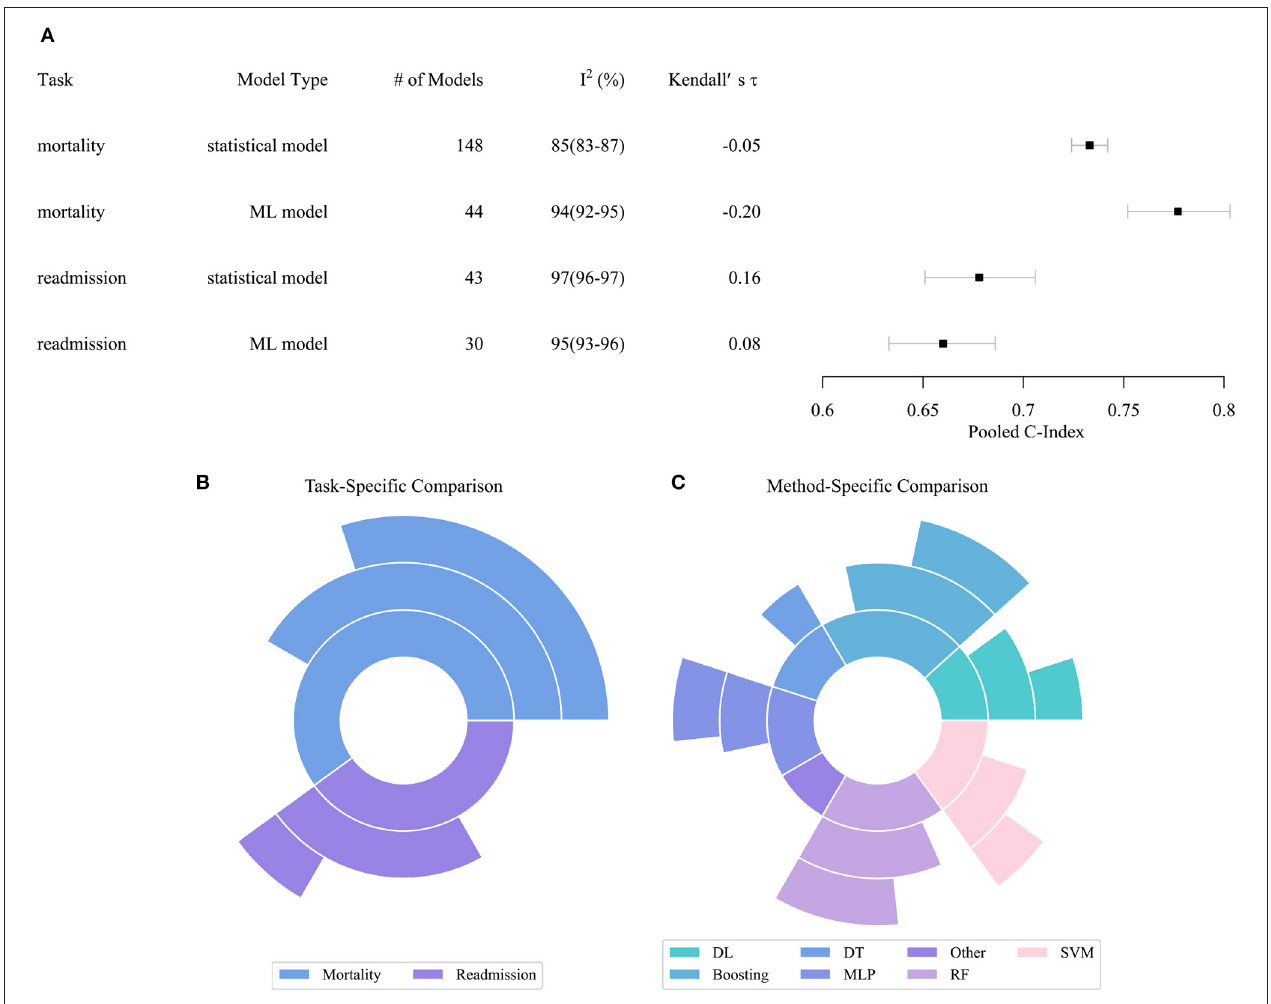
FIGURE 2 | Performance distribution of statistical and ML models. (A) Pooled C-index of meta-analysis with respect to tasks and model types. (B) Task specific comparison result. (C) Model specific comparison result. In subplots (B,C) , the inner pie indicates the number of pairwise comparisons between ML models and statistical models. The middle pie indicates the number of pairs in which the ML model achieved better performance, while the outer pie indicates the number of pairs in which the superiority of ML models reached statistical significance. ML, Machined Learning; DL, Deep Learning; DT, Decision Tree; SVM, Support Vector Machine; MLP, Multi-Layer Perceptron; RF, Random